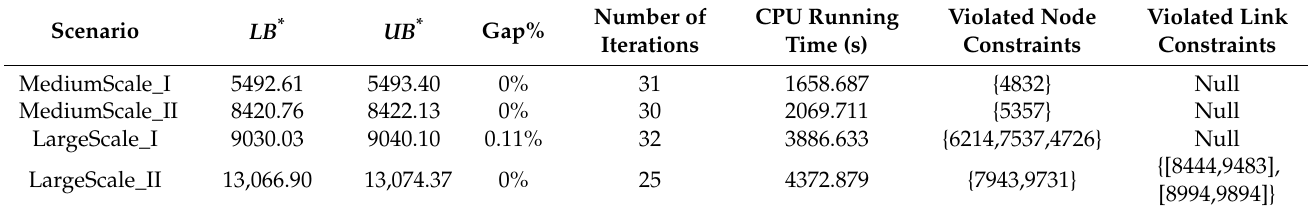
Table 13. Real-world case experiment